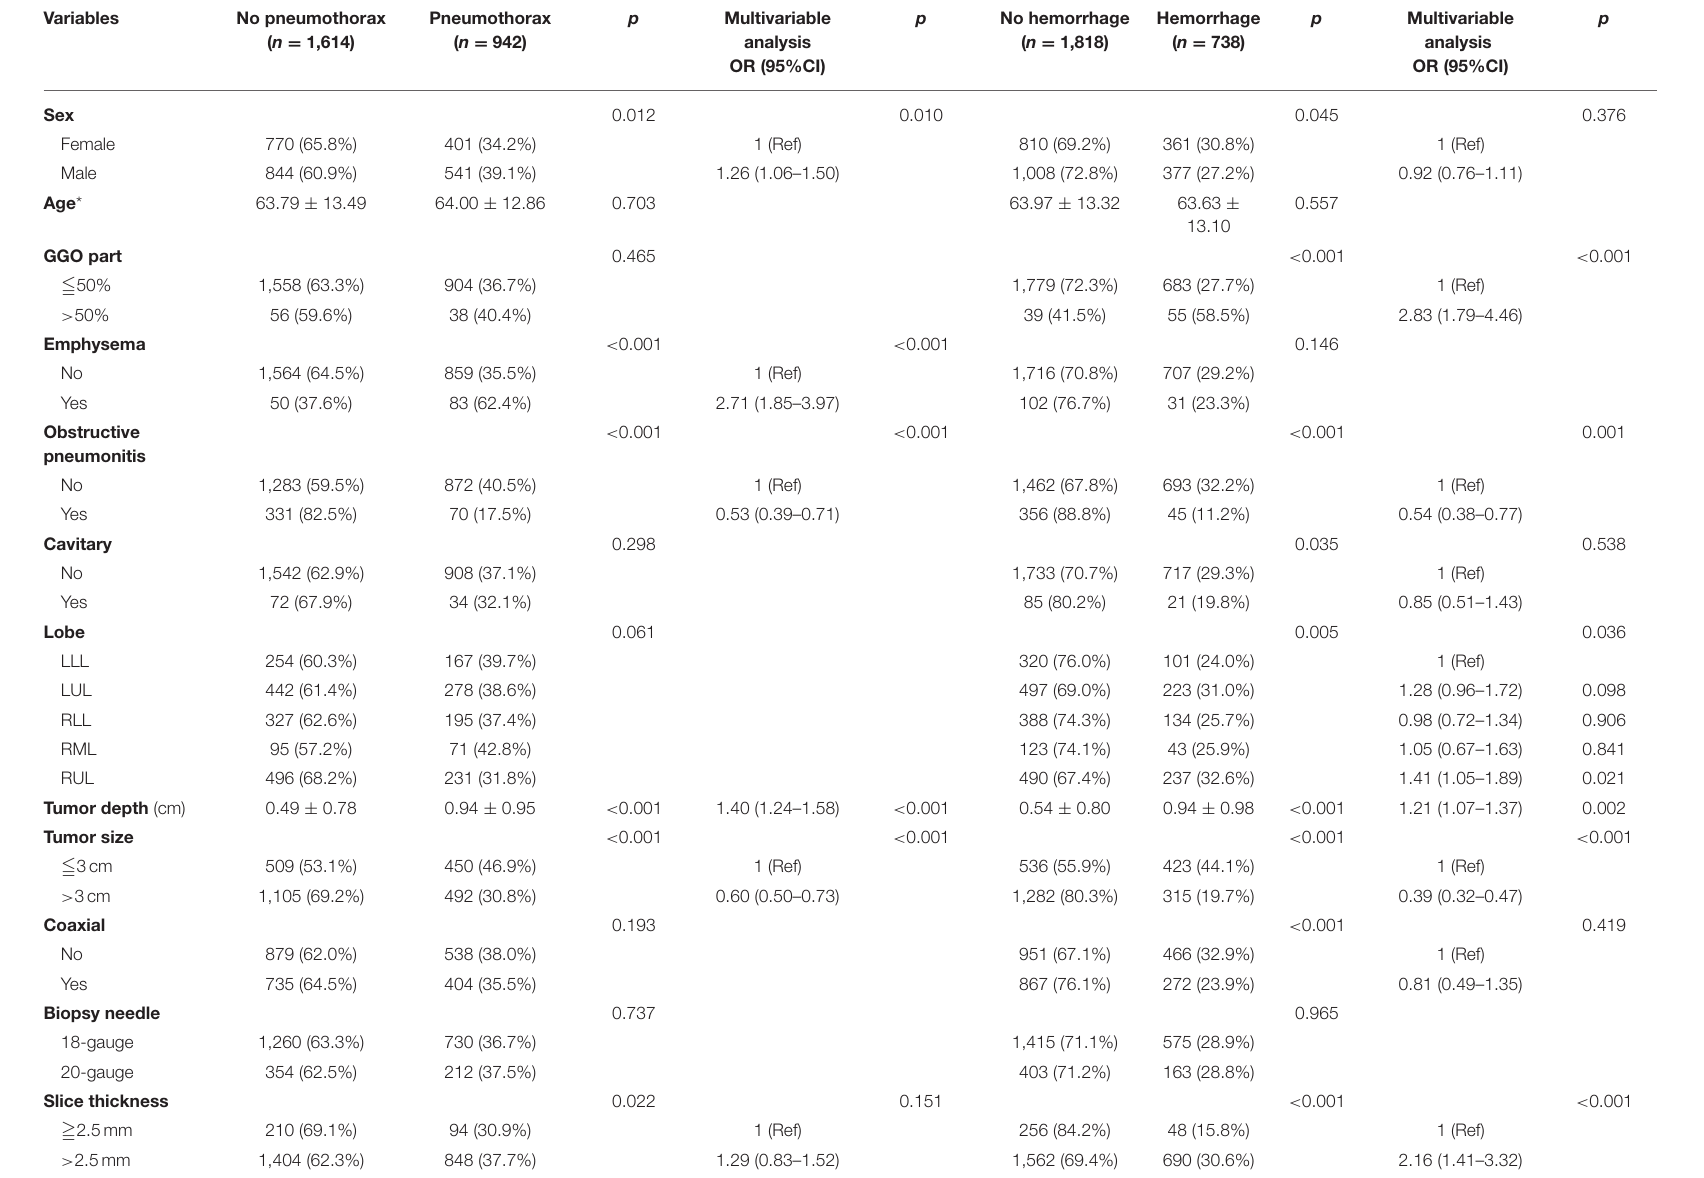
TABLE 5 | Predictors for procedure-related